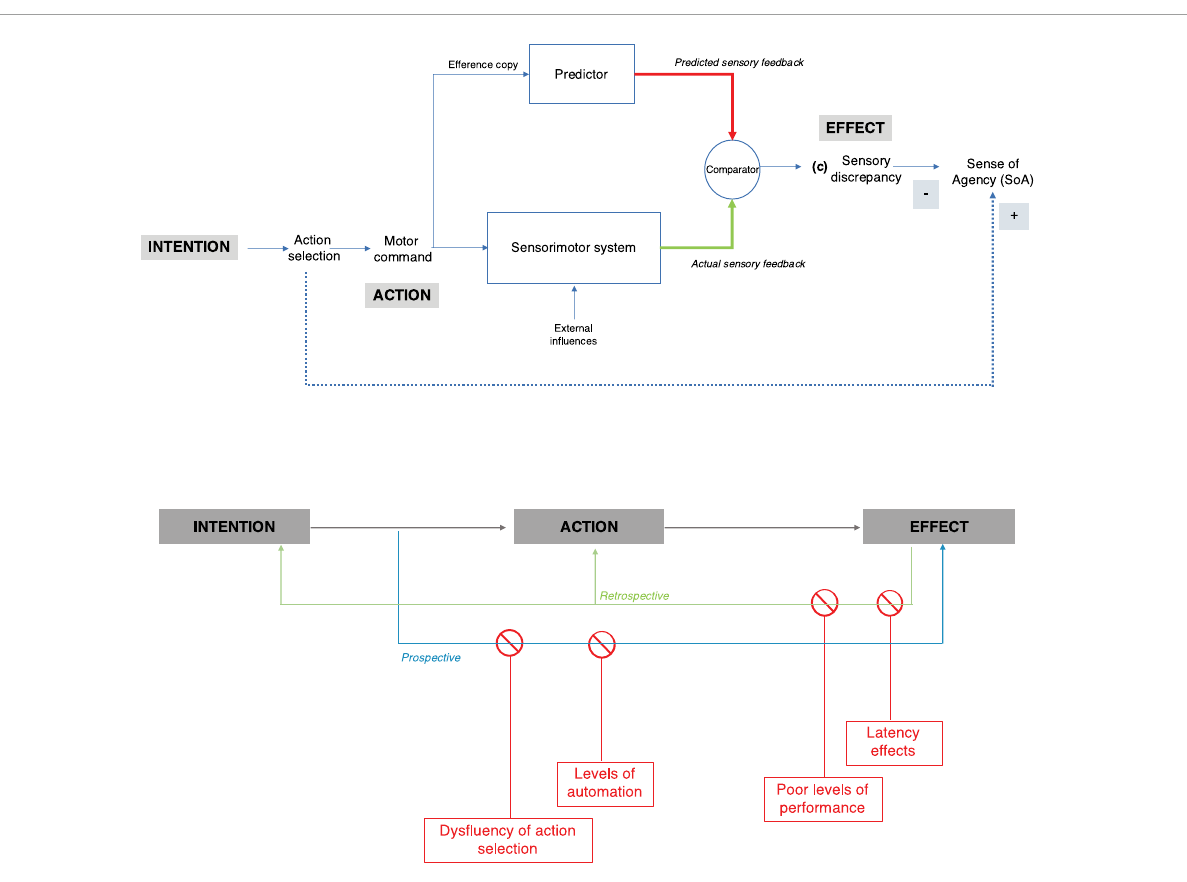
FIGURE2 (Top) Computational model of the sense of agency (drawn using source data from Blakemore et al., 2002). (Bottom) Modulators of the sense of agency along the intention-action-effect chain (drawn using source data from Chambon and Haggard,